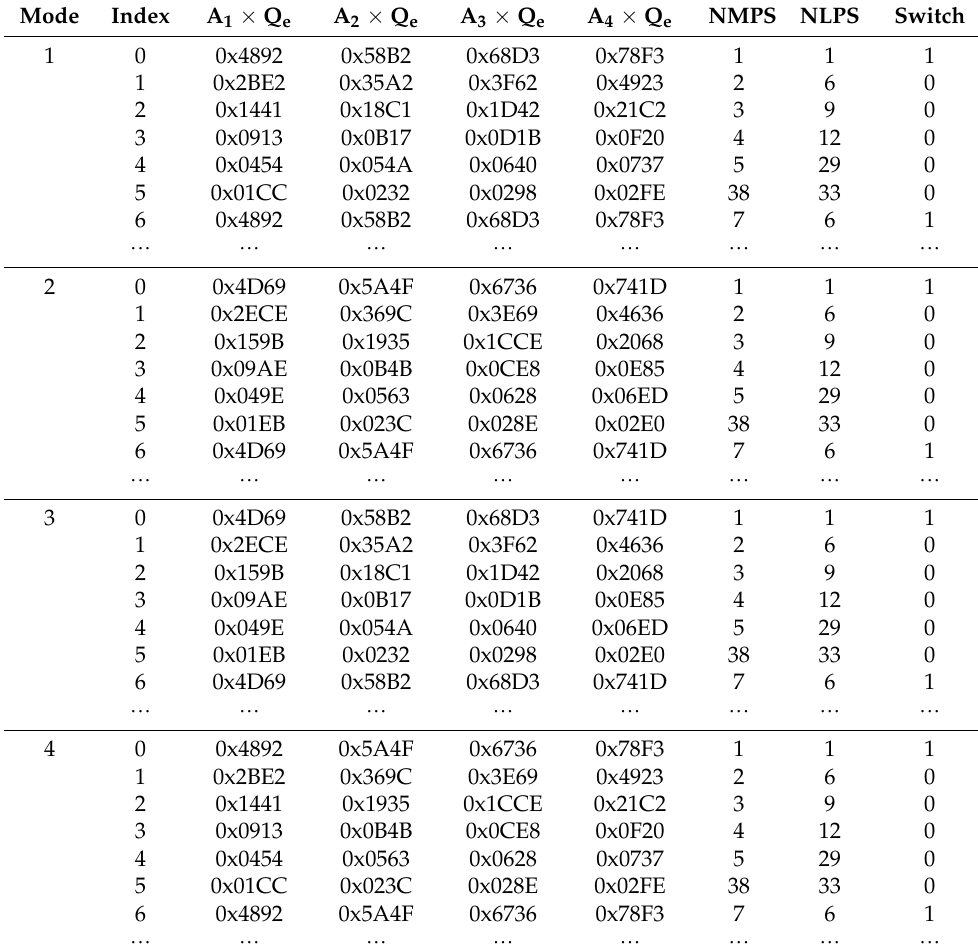
Table 7. (A i × Q e ) lookup table (47 × 4, α = 1, β = Table 6. Four modes of 4-level quantization.